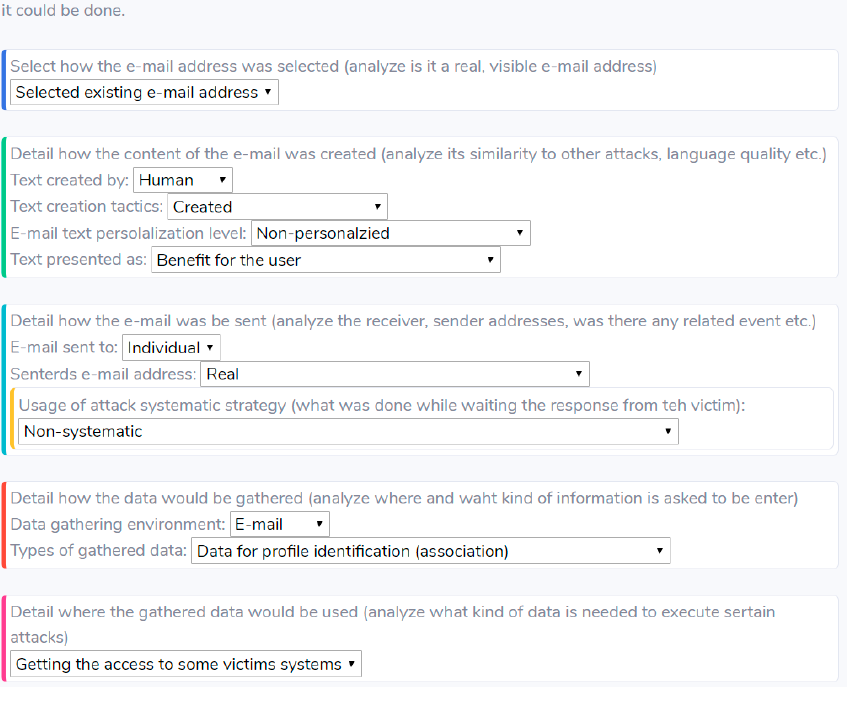
Figure 5. Form for e-mail-based phishing attack notating.